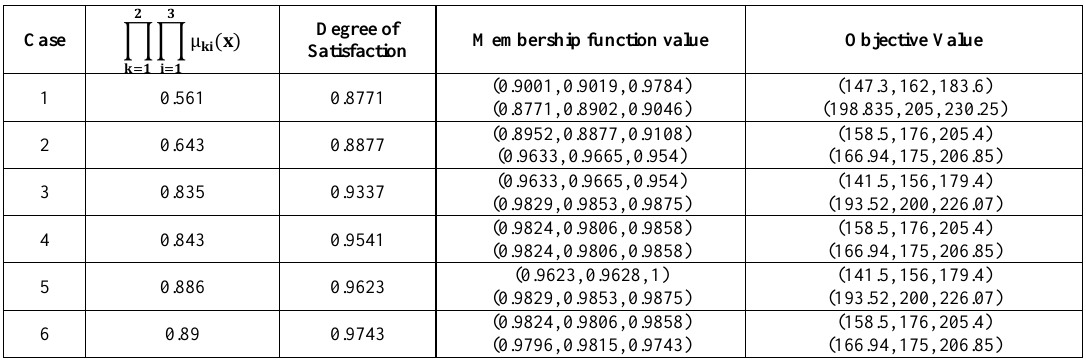
Table 4. Summary results for α =